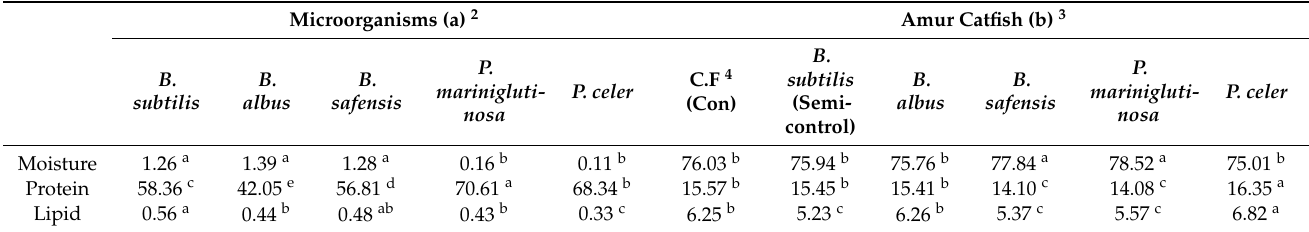
Table 2. Whole-body proximate compositions of bacterial strains and Amur catfish fed with commercial feed and 5% freeze-dried bacteria biomass-supplemented feed at end of 8-week experiment 1 .